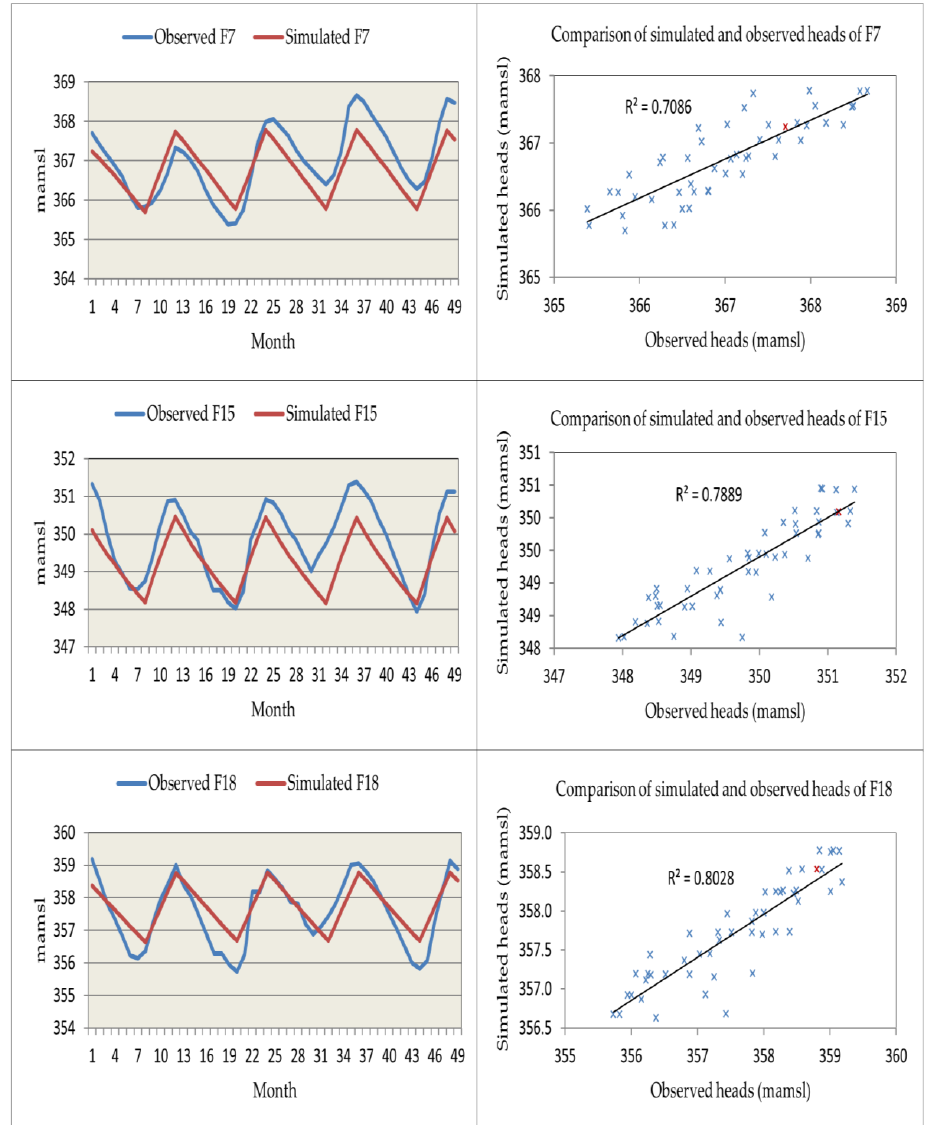
Figure 10. Simulated and observed heads during the transient calibration in the Klela basin